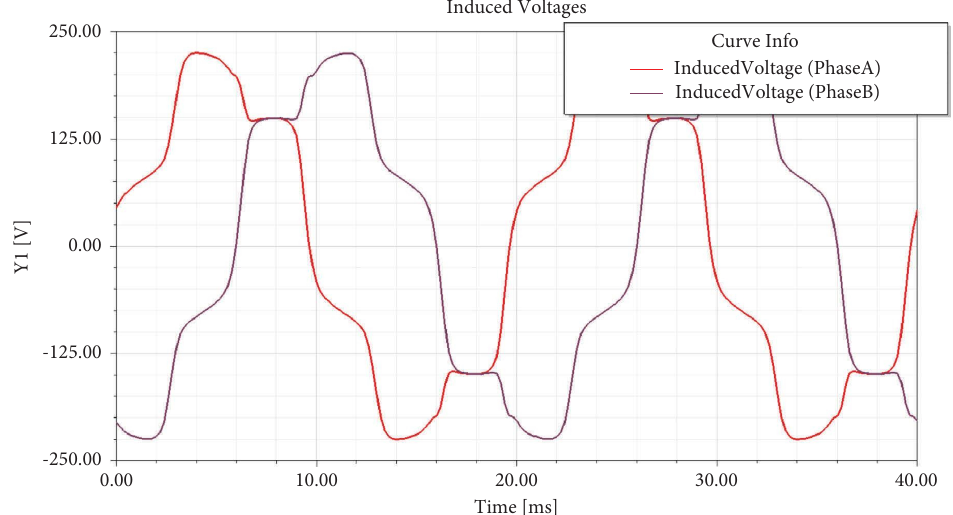
Figure 16: Back electromotive force (EMF) curves of 4-pole 12-slot motor.